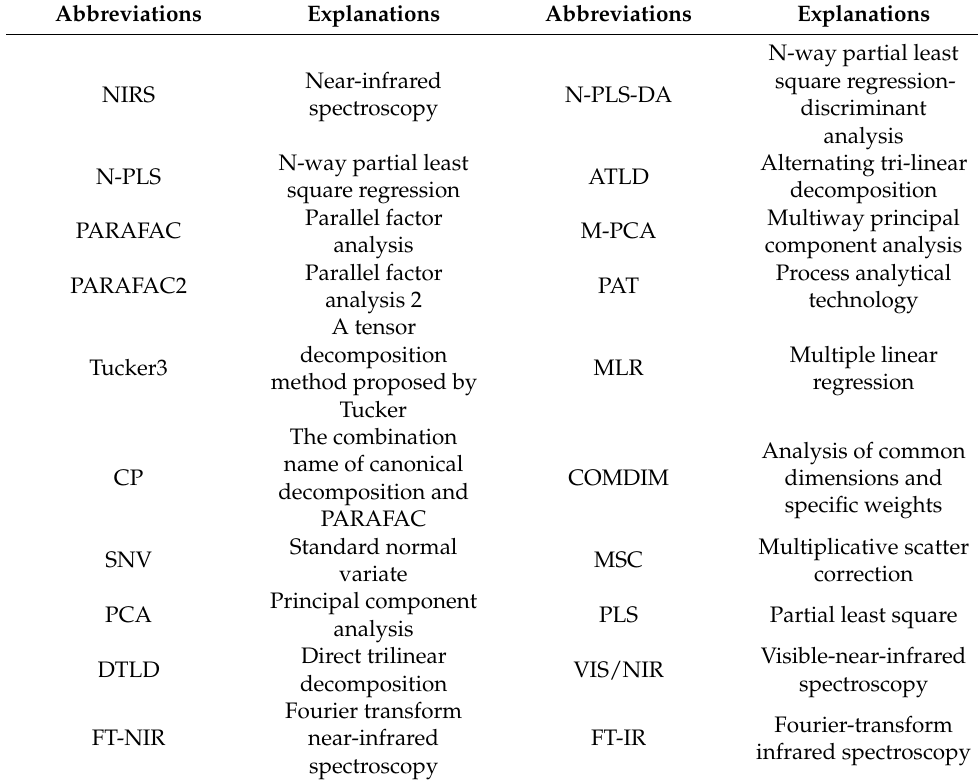
Table 1. The meaning of used abbreviations in the